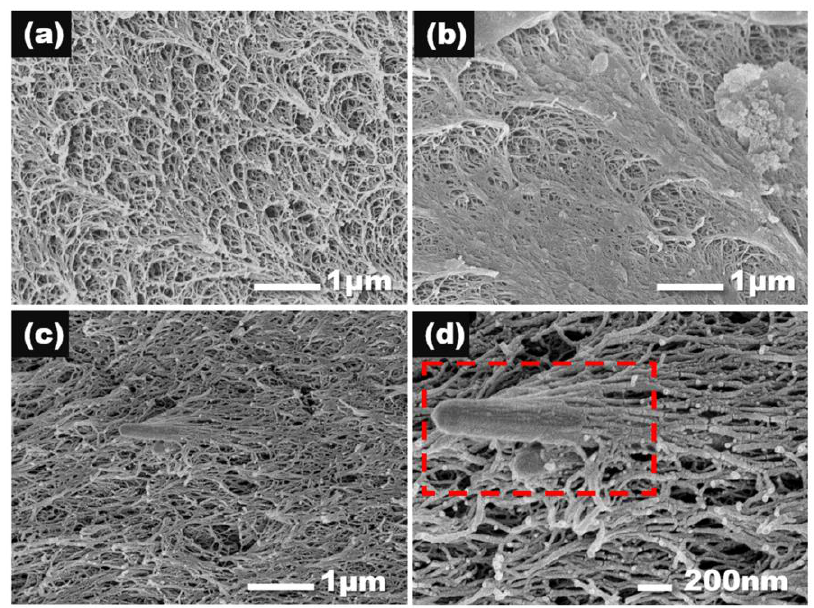
Figure 5. SEM images of aerogel samples. ( a ) PI-0 treated with liquid nitrogen; ( b ) PI-0 for tensile test; ( c ) PI-2; ( d ) PI-2 in high resolution.